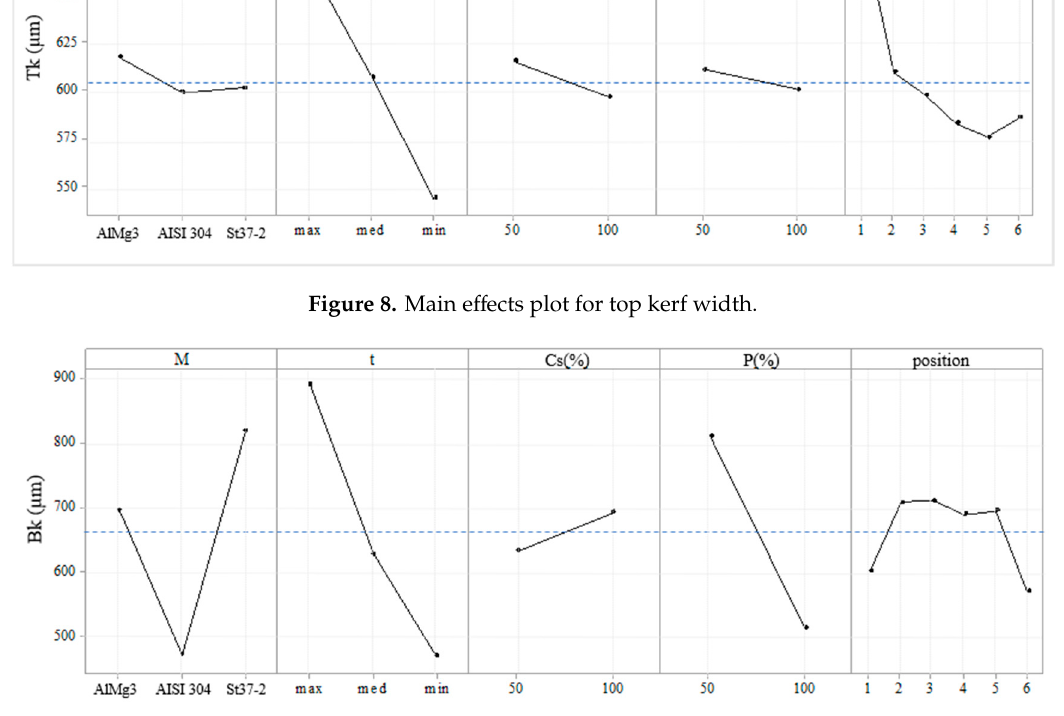
Figure 9. Main e ff ects plot for bottom kerf width. Figure 9. Main effects plot for bottom kerf width. Figure 9. Main effects plot for bottom kerf width.